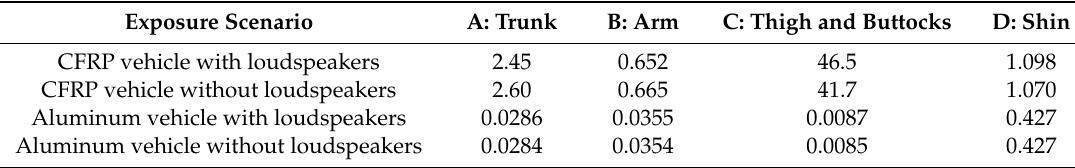
Figure 6. Comparison of vehicle magnetic field strength with and without the loudspeakers for different vehicle body materials ( a ) CFRP, ( b ) aluminum. Table 2. Comparison of the peak spatial-average magnetic field strength (A/m) in different driver model measurement positions with and without loudspeakers in the vehicle.